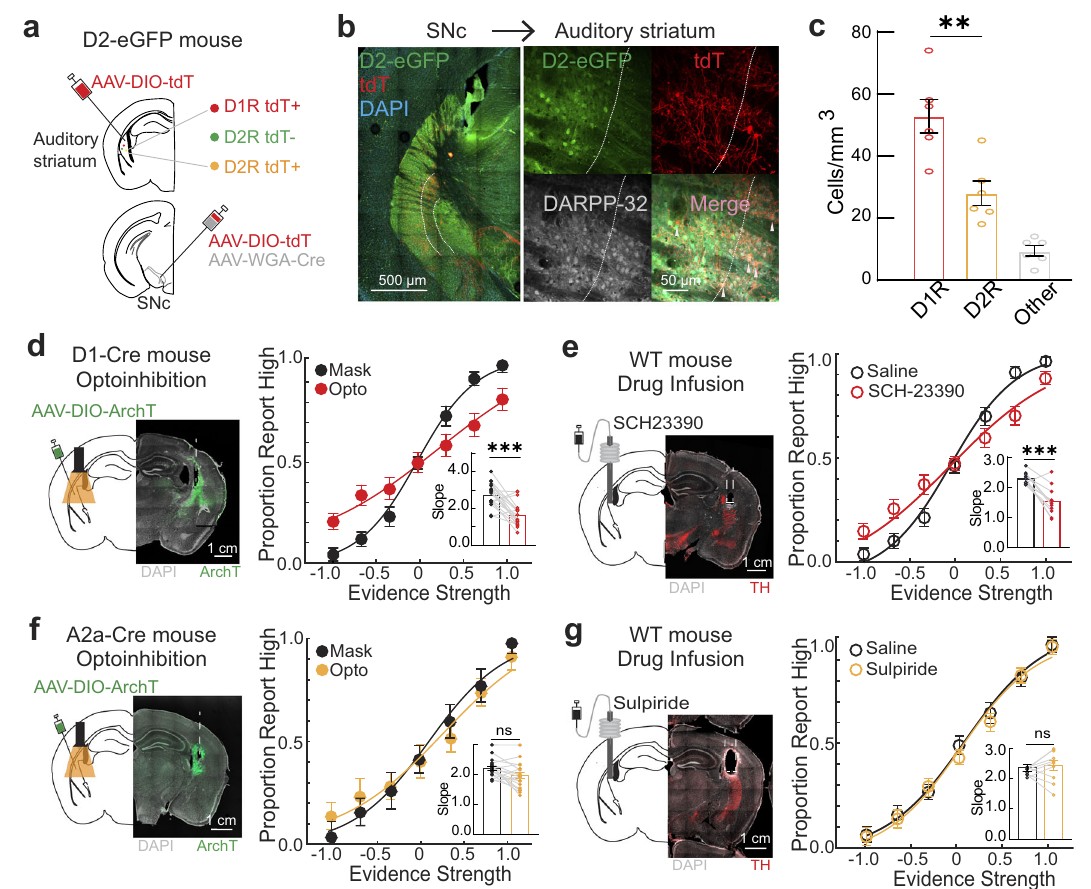
Fig. 4 | The D1 but not D2 pathway regulates auditory discrimination. a Schematic of transsynaptic anterograde tracing from the substantia nigra pars compacta (SNc) to the auditory striatum in D2-eGFP transgenic mice. b Left, representativeimagingoftranssynapticallylabeledtdTomato(tdT) + mediumspiny neurons(MSNs)intheauditorystriatum.Right,imagingoftdT+,DARPP-32+(MSN marker), and D2-eGFP+ neurons. White traces denote the D1R-rich zone. c Quanti fi cation labeled neuron distribution ( n =18 sections across 6 mice; ** p =0.0040, two-sided unpaired t -test). Each dot represents a density per mouse. d Left, schematic for optogenetic silencing of D1-MSNs and representative histol- ogy. Right, psychometric performance during auditory stimulus – based silencing comparingoptogeneticlightvs.maskinglighttrials.( n =4miceacross18sessions). Insert:comparisonofcorrespondingregressionslopesforindividualsessions.Bars represent the mean and dots represent individual sessions (*** p =0.0002, two- sidedWilcoxonrank-sumtest). e Left,schematicforbilateraldrugmicroinfusionof D1R antagonist and representative histology. Right, psychometric performance